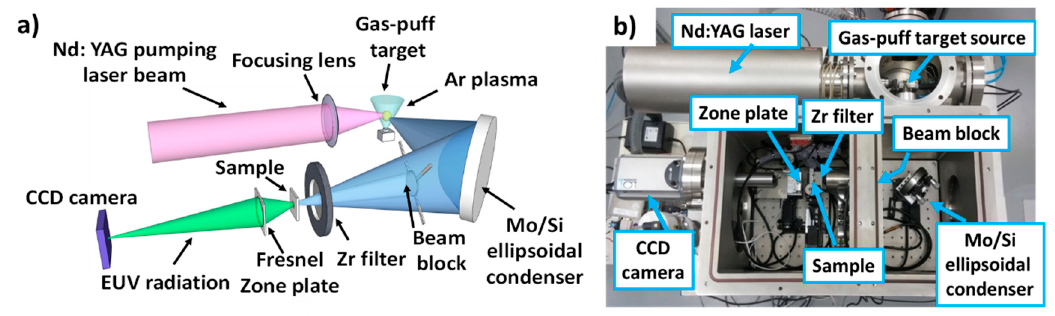
Figure 3. ( a ) Scheme and ( b ) external view of the extreme ultraviolet (EUV) microscope. Figure modified, based on [71].